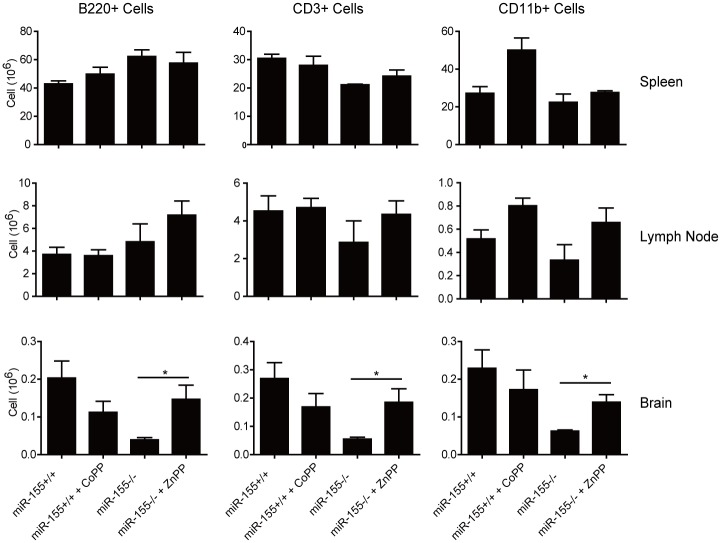
ZnPP treatment enhanced different cell types infiltrating into the brain of miR-155
-/- mice.Cells were isolated from spleen, lymph nodes (LN) or brain 20 days after immunization. Numbers of B cells (B220+), T cells (CD3+) and monocytes/macrophages (CD11b+) were assessed by flow cytometry from spleen, LN and brain of miR-155
+/+ or miR-155
-/- mice immunized with MOG35-55 and treated or not treated with CoPP or ZnPP. *: p<0.05. Data are shown as mean ±SEM. n = 6 mice per group. The results are representative of two independent experiments.